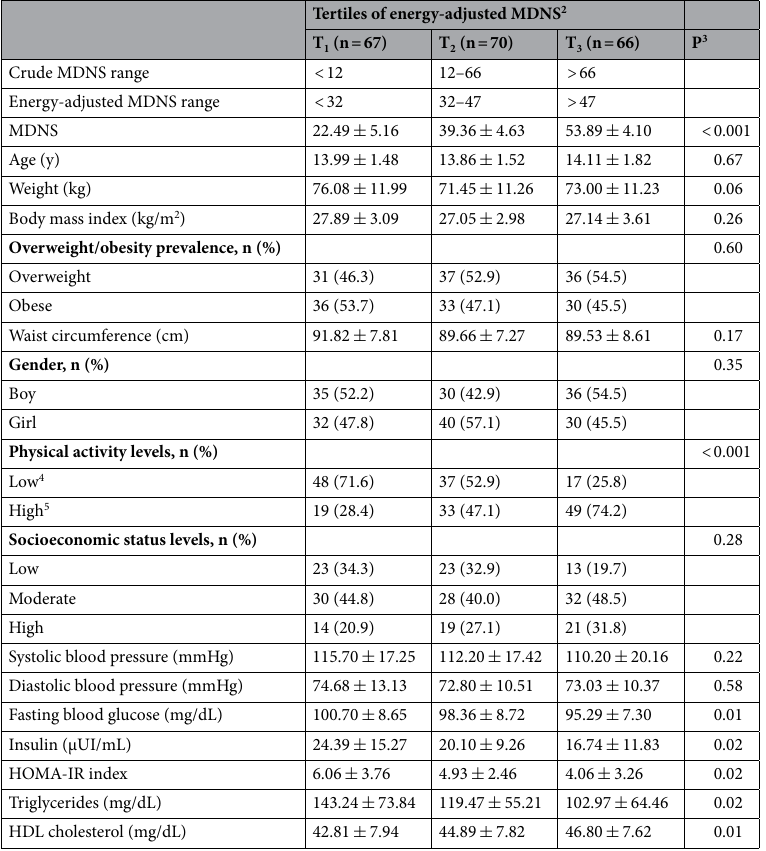
Table 1. General characteristics of study participants across tertiles of the mehtyl donor nutrients score (n = 203) 1 . 1 All values are means ± standard deviation (SD), unless indicated. 2 MDNS components were adjusted for energy intake based on residual method. 3 Obtained from ANOVA for continuous variables and chi-square test for categorical variables. 4 Includes sedentary and low-active participants. 5 Includes active and very-active